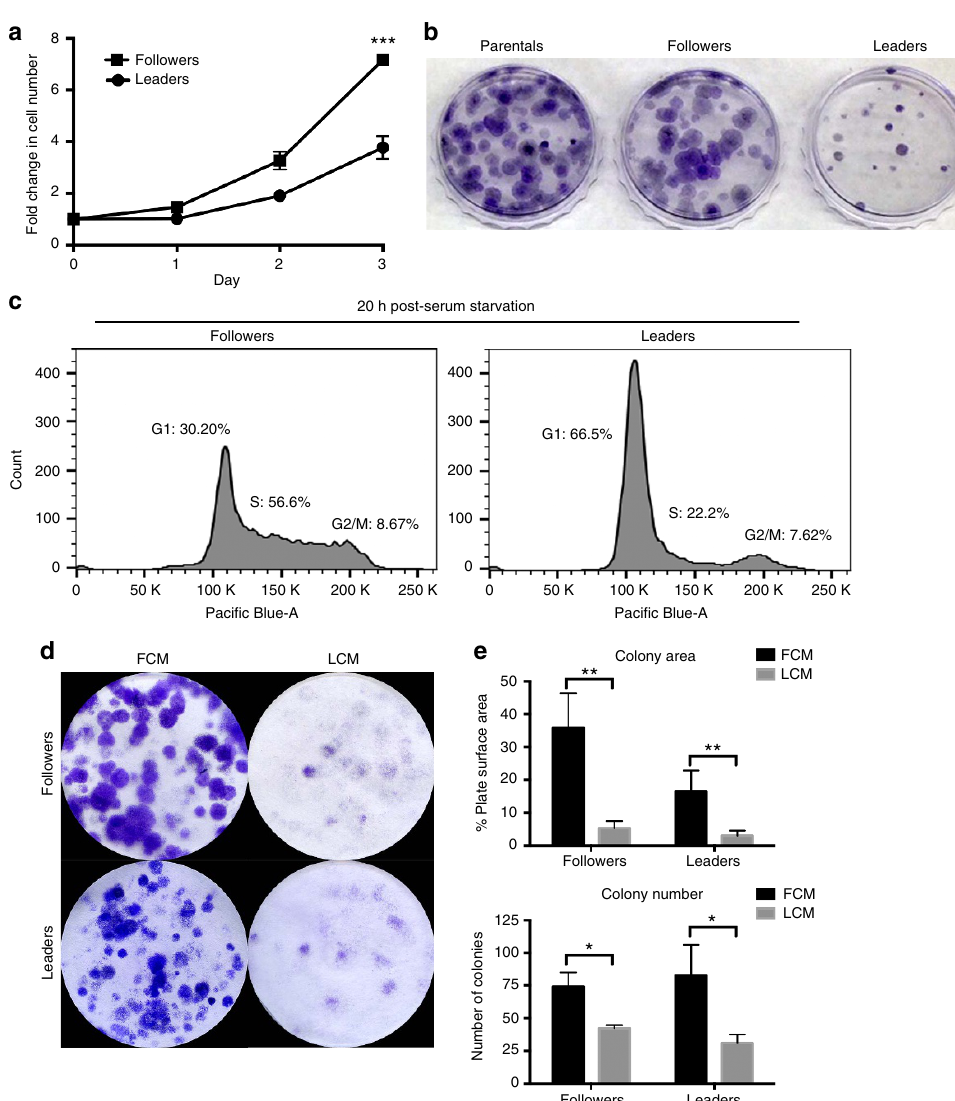
Figure 6 | Follower cells are a proliferative subpopulation promoting leader cell growth via a secreted factor. ( a ) Graph showing H1299 follower and leader cell growth over 3 days. *** P o 0.001. ( b ) Colony formation assay of H1299 parental, follower and leader cells. ( c ) Cell cycle analysis of H1299 follower and leader cells that were serum starved, and then released for 20h with normal growth media. ( d ) Colony formation assay of H1299 follower and leader cells. Cells were plated in conditioned media from FCM or LCM. Images taken 2 weeks after plating. ( e ) The colony size and number of colonies from d were measured using ImageJ software. * P o 0.05, ** P o 0.01 using a Student’s t -test. Error bars denote the